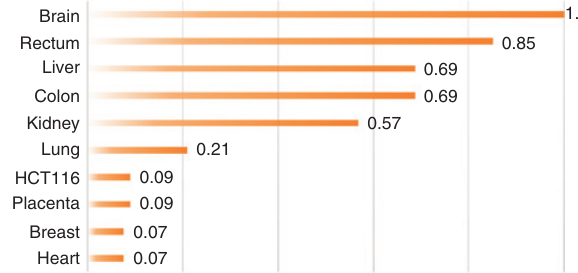
Figure 1: 5-Hydroxymethylcytosine levels relative to brain tissue. Fold-change was calculated by dividing tissue total percent 5-hmC by brain total percent 5-hmC. HCT116 (a colon cancer cell line) showed ~ 9-fold decrease in 5-hmC levels compared to normal colon tissue healthy colon. Data adapted from Ref. (69).